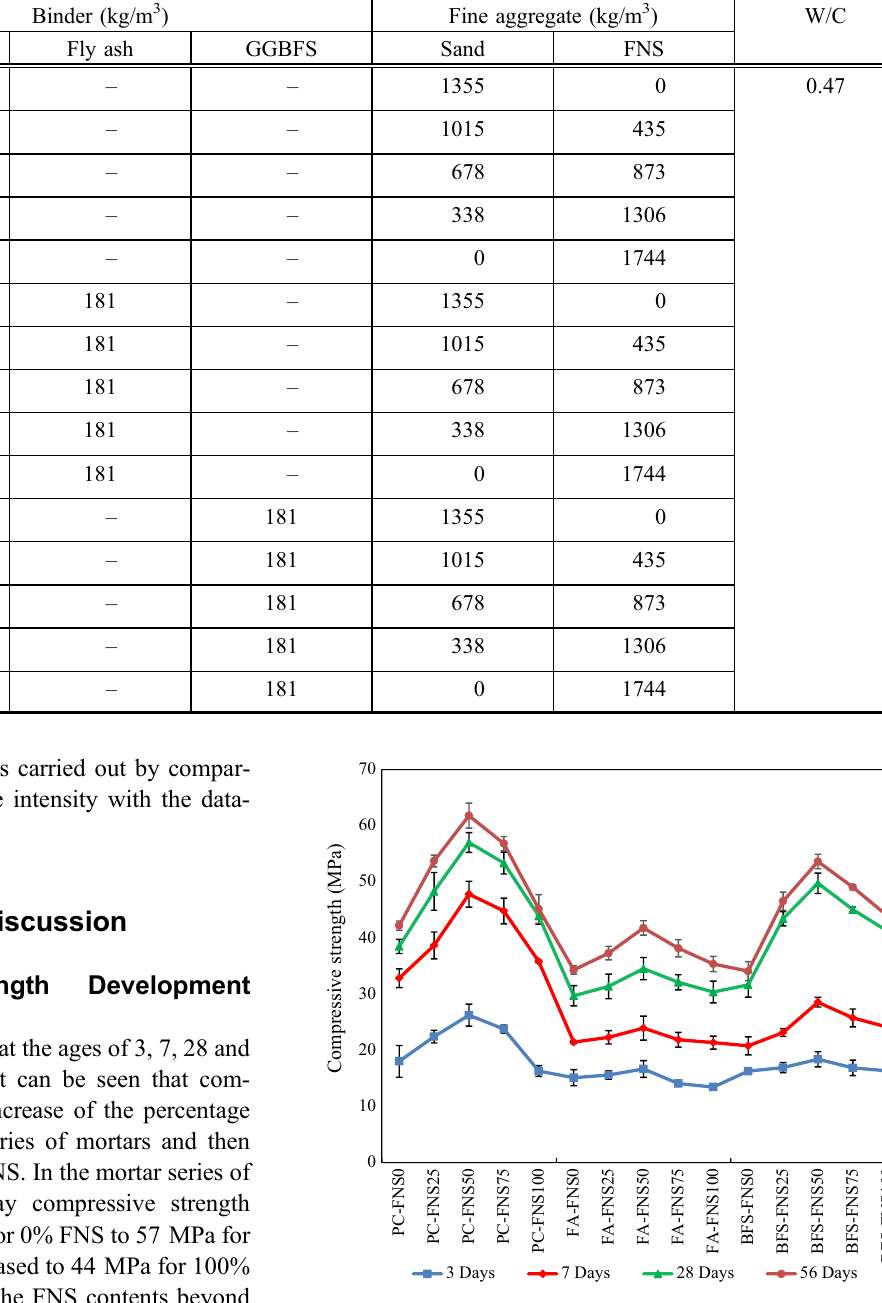
Fig. 4 Compressive strength development of mortar mixtures (error bars are at one standard